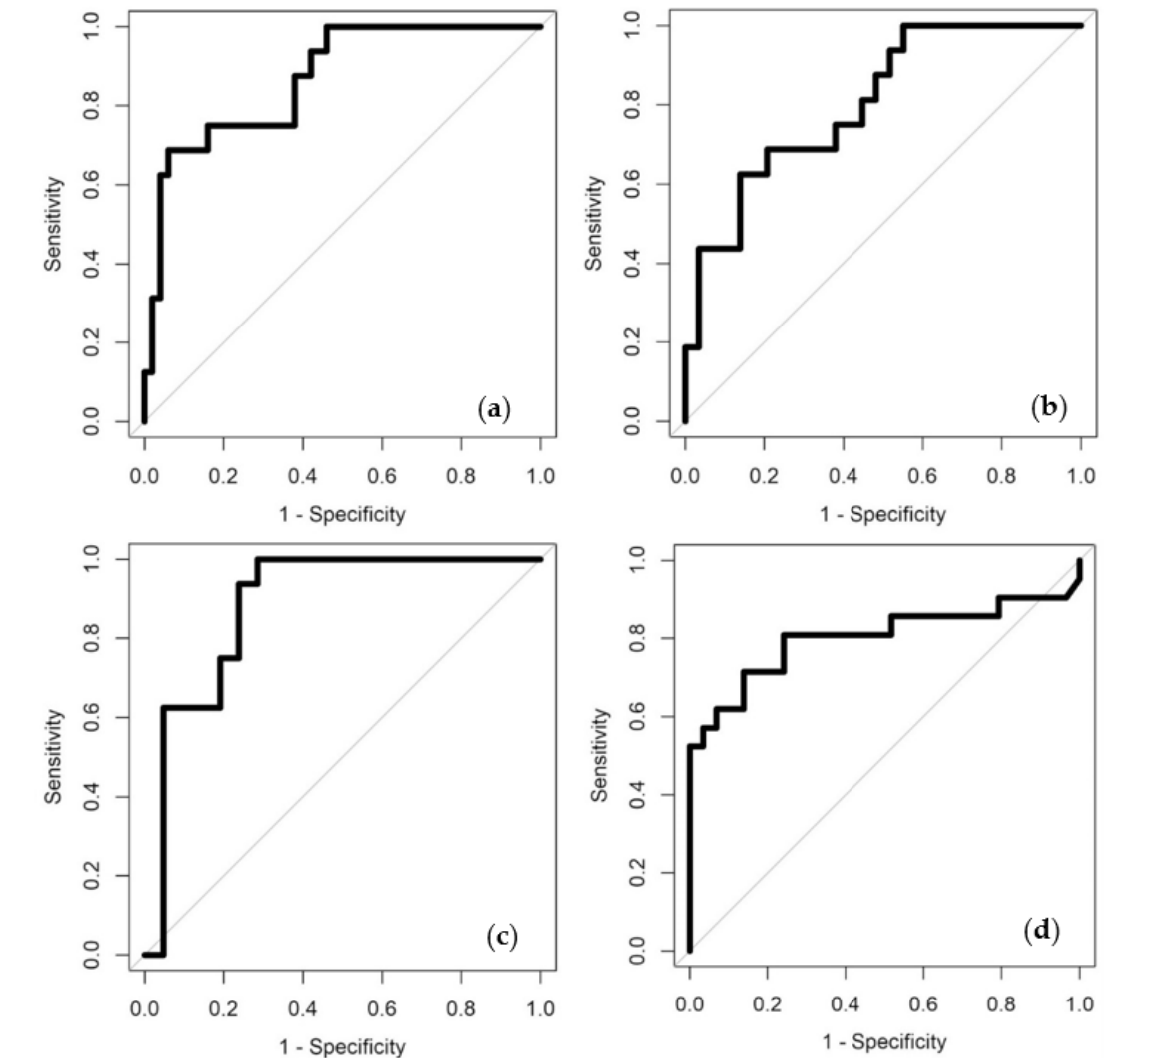
Figure 4. ROCs for patient group combinations ( a ) COVID-19 positive (symptomatic and asymp- tomatic) vs. COVID-19 negative (control) ( b ) COVID-19 positive (symptomatic) vs. COVID-19 negative (control), ( c ) COVID-19 positive (asymptomatic) vs. COVID-19 negative (control) and ( d ) COVID-19 positive (symptomatic) vs. COVID-19 positive (asymptomatic). We see that all the results show a statistically significant difference between the groups, with COVID-19 positive (symptomatic and asymptomatic) vs. COVID-19 negative (control) producing an AUC of 0.87. Similar results were obtained comparing COVID-19 positive (symptomatic) vs. COVID-19 negative (control) and COVID-19 positive (asymptomatic) vs. COVID-19 negative (control). However, it was found that the Covid positive (asymp- tomatic) results were higher than the symptomatic (0.88 vs. 0.80 AUC). Furthermore, we were able to distinguish asymptomatic and symptomatic patients with a high degree